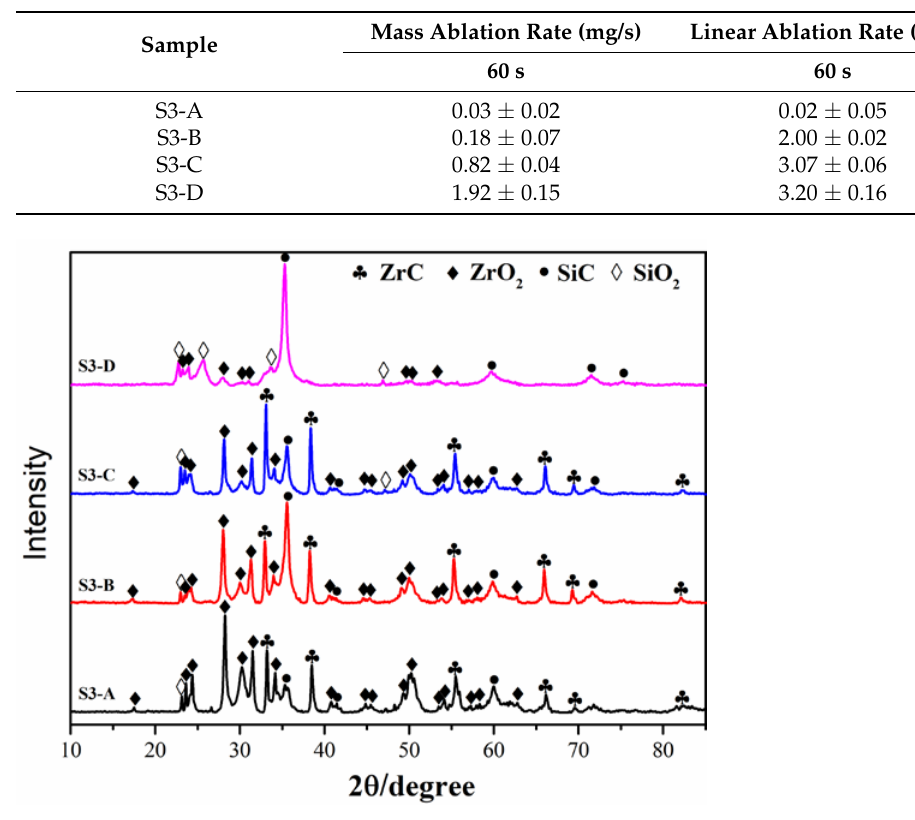
Figure 10. Macrographs of the S3 coatings after 60 s ablation time. ( a ) S3-A; ( b ) S3-B; ( c ) S3-C; ( d ) S3-D. Table 4. The mass and linear ablation rate of S3 coatings after 60 s ablation.